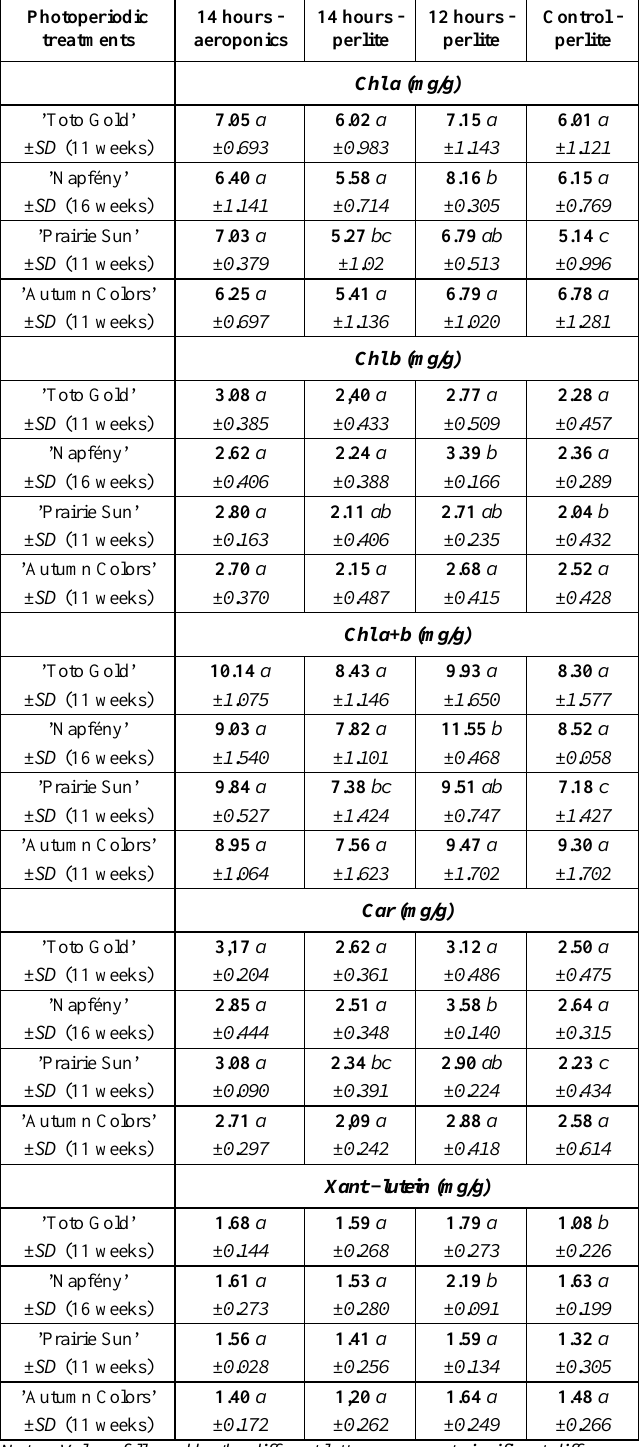
Table 5. Photosynthetic pigment content (mg/g) of Rudbeckia hirta L. plantlets depending on photoperiodic lighting treatments and media (University of Debrecen, Biological Research and Plant Experiment Greenhouse - Biodrome, Debrecen, Hungary,